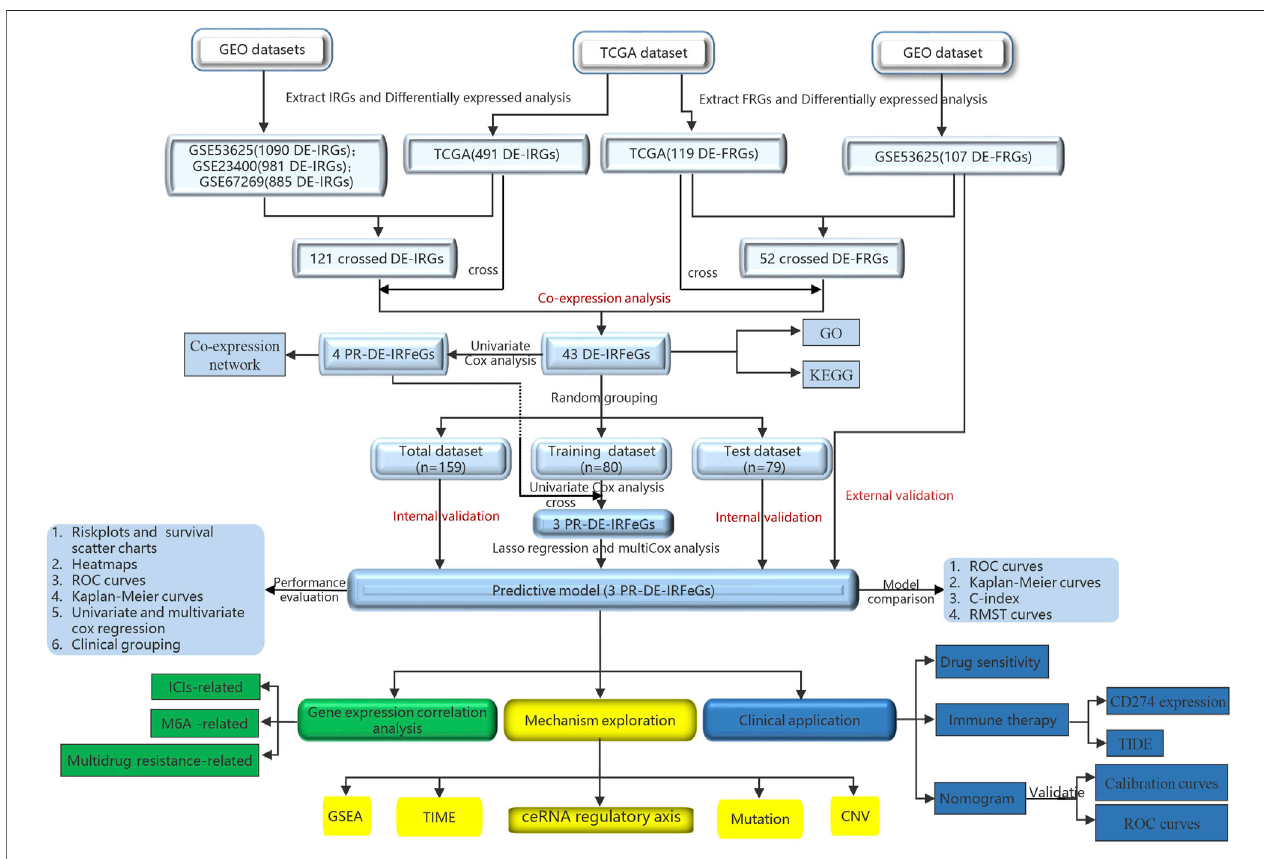
FIGURE 1 | Research diagram of the informatics